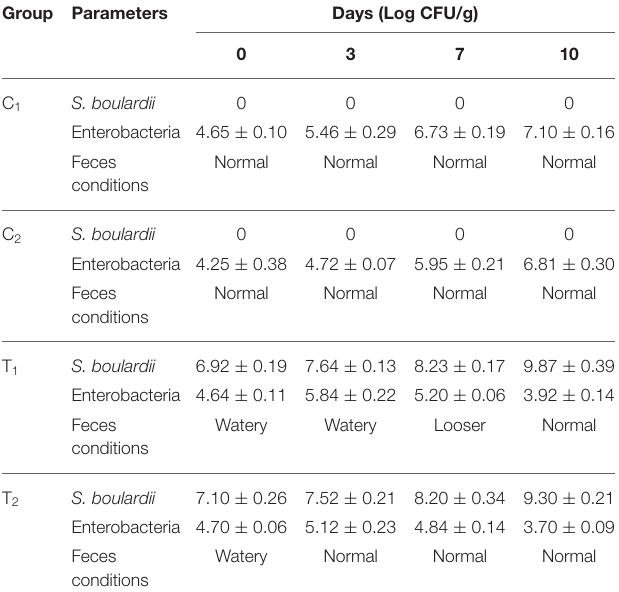
TABLE 5 | S. boulardii and Enterobacteria counts along with feces conditions in tested the mice feces. Group Parameters